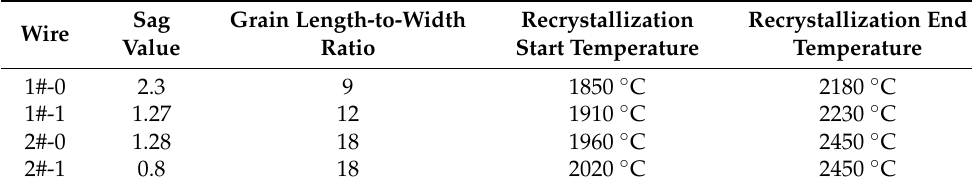
Table 2. High-temperature performance test results of the